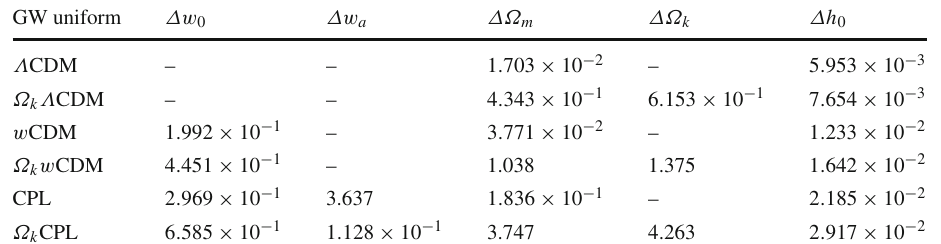
on cosmological parameters from the ET GWs for the nonuniform distribution of GW sources